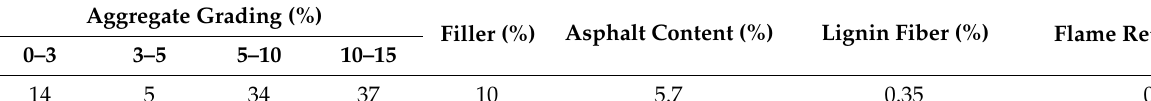
Figure 1. Production grading curve.